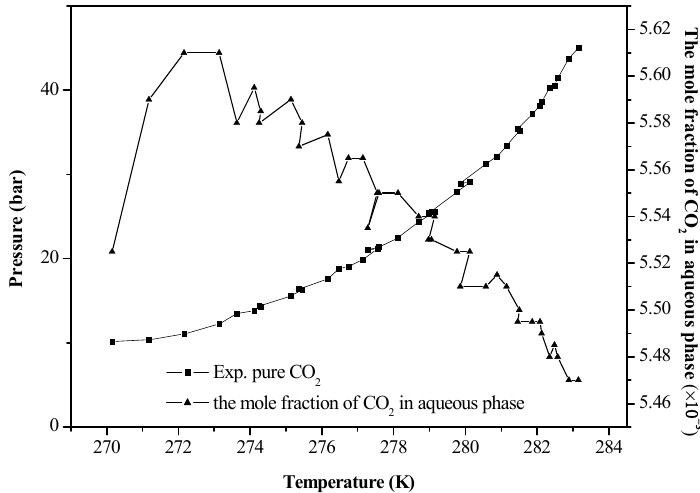
Figure 8. The experimental data and the mole fraction of carbon dioxide in aqueous phase for CO 2 + water systems under the phase equilibrium. The experimental data were reported by Ma et al. [42].